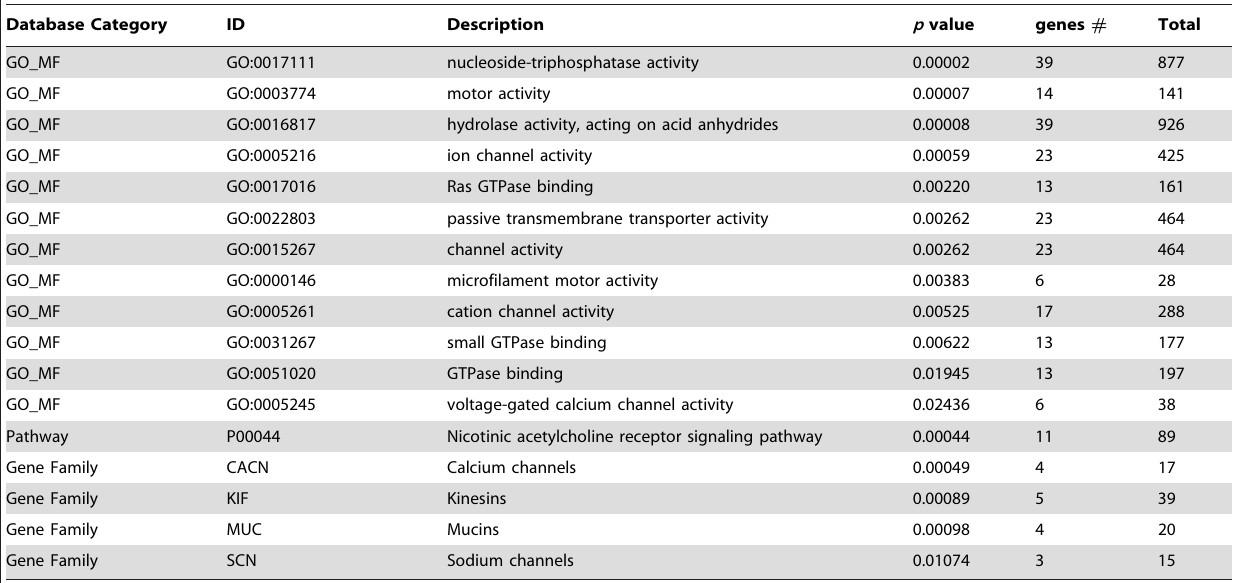
Table 6. Heart GO enrichments analyses.